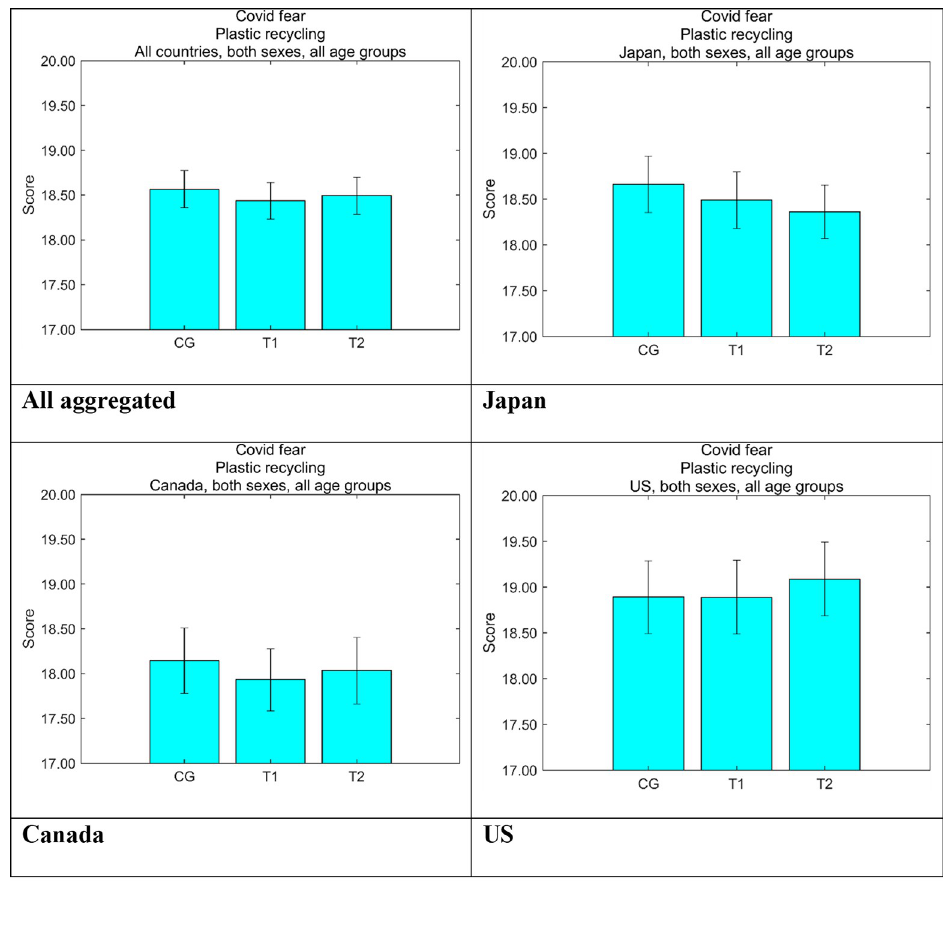
Fig 9. Fear about COVID-19 by group. Higher values on the vertical axis indicate higher perceived danger of COVID-19. Error bars show 95% confidence intervals. CG, control group; T1, treatment group 1; T2, treatment group